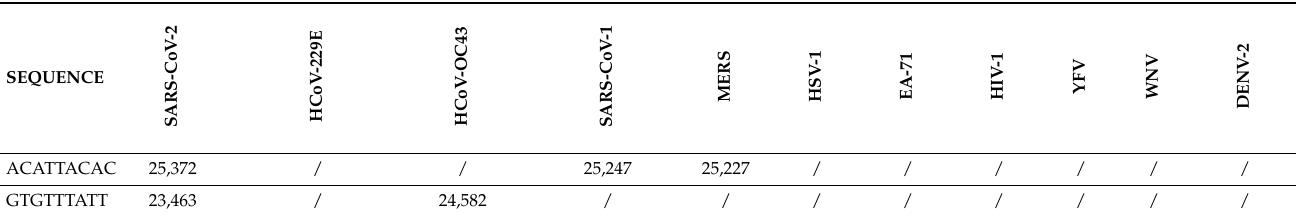
Table 1. The nucleic sequence ACATTACAC were found in SARS-CoV-2, SARS-CoV-1 and MERS, whereas GTGTTTATT in the genome of SARS-CoV-2 and HCoV-OC43. Starting positions of each sequence are reported and, if not present, this is indicated as